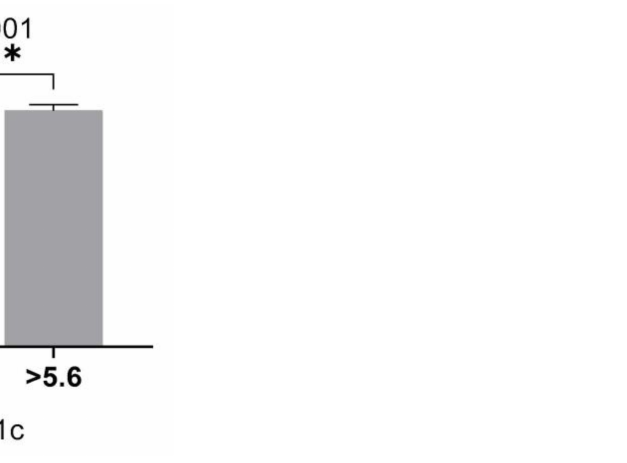
Figure 3. Comparison of serum BCAA levels in the study population according to HbA1c level.